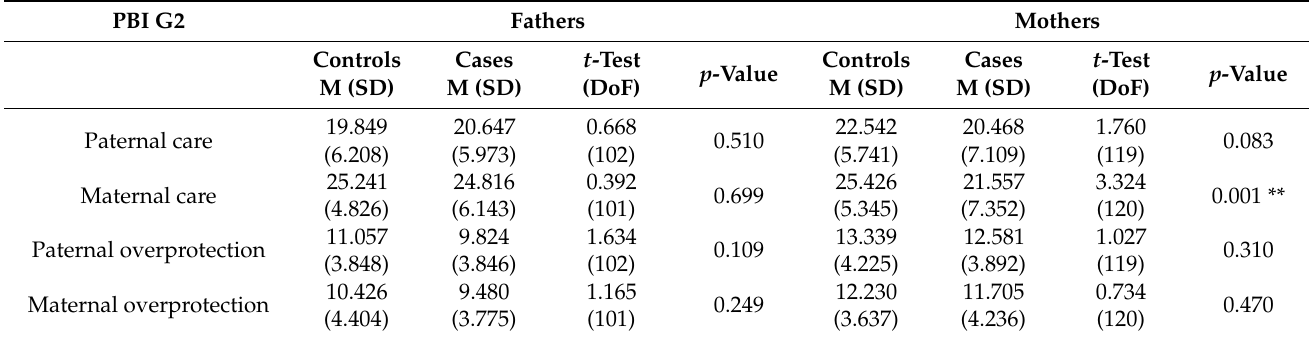
Table 5. The t -test G1 controls vs. cases.